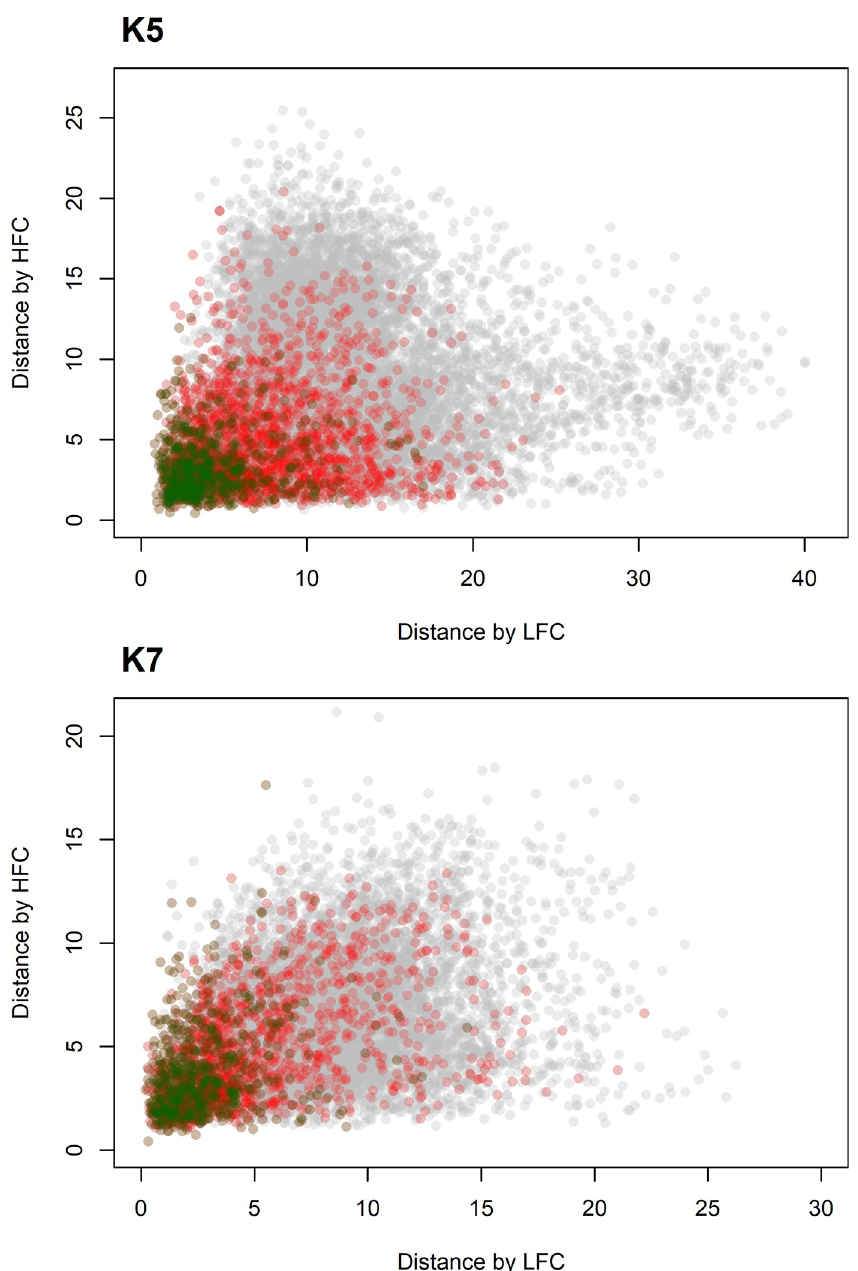
Fig 2. Scatterplot of distances calculated through dynamic time warping for lower- and higher-frequency components of K5 (top) and K7 (bottom) call types. Green—distances between the lower- and higher-frequency components from the same families; red–between different families from the same pods; grey–between different pods.